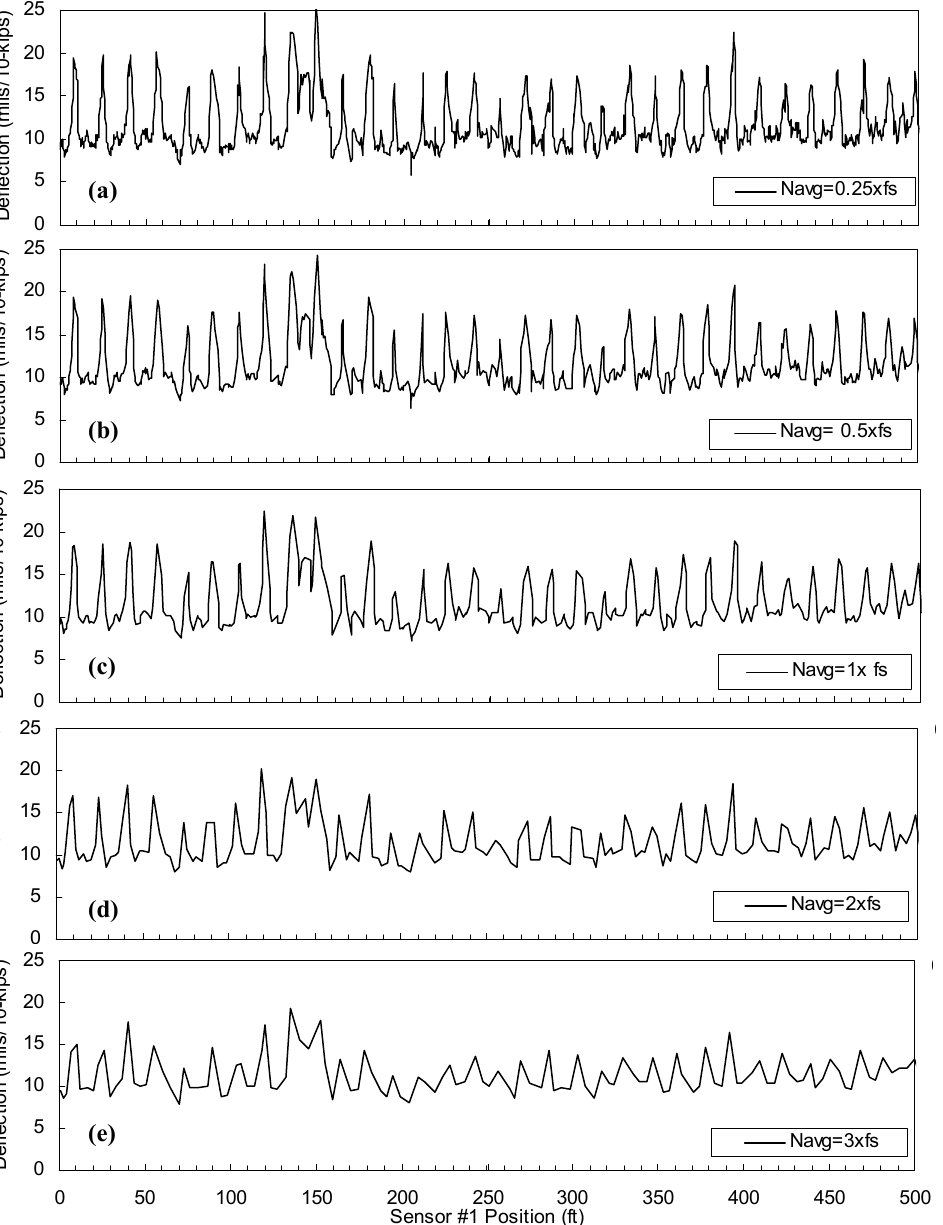
Figure 9. Continuous deflection profiles (Sensor #1) constructed by various FIR filters with different N avg but the same IIR filter (BW 20 = 3.9 Hz). ( a ) 0.25 × f s ; ( b ) 1 × f s ; ( c ) 2 × f s ; ( d ) 3 × f s .